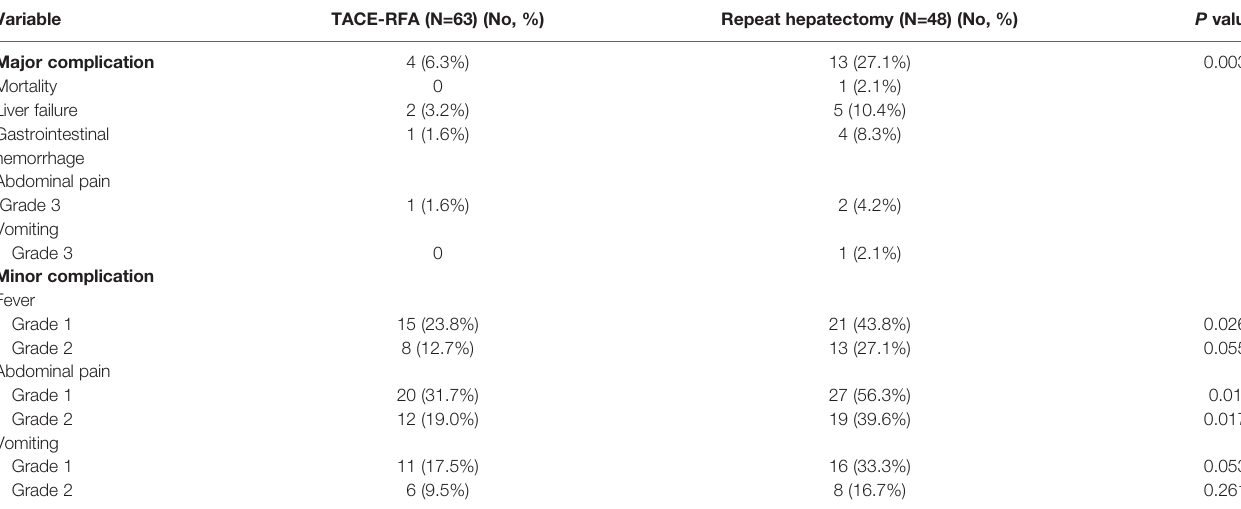
TABLE 5 | Complications after